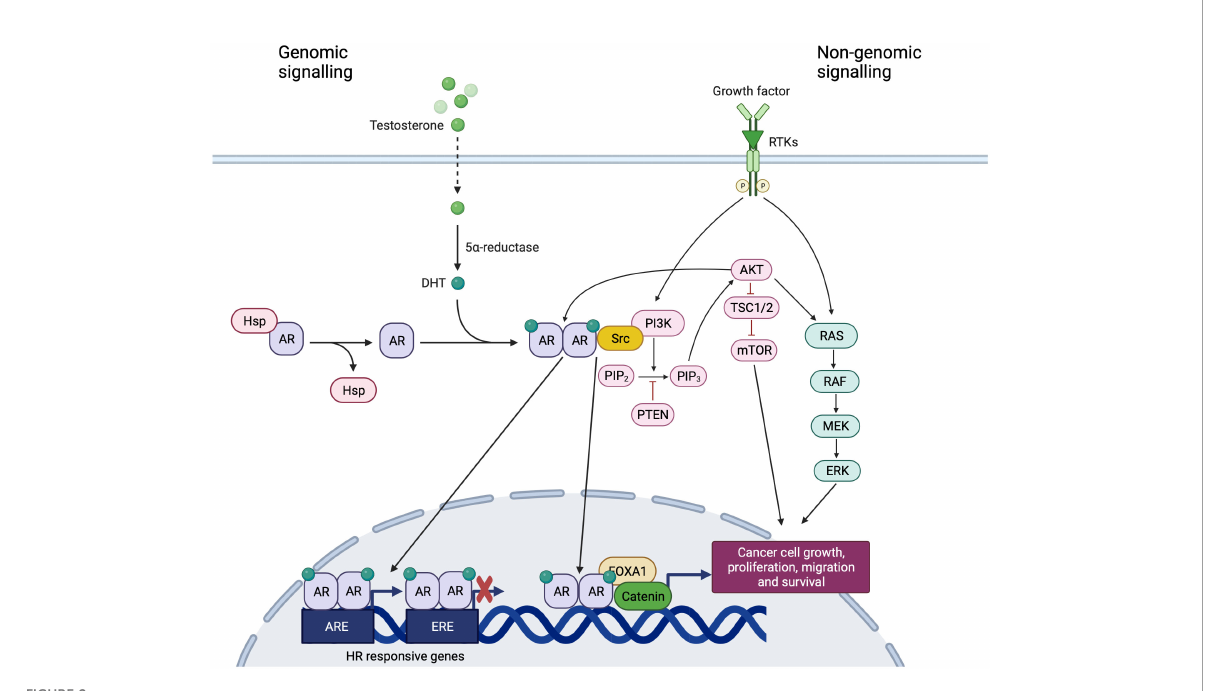
FIGURE 2 Genomic and non-genomic signaling of AR. Created with BioRender.com. In the absence of ligand, AR is located in the cytoplasm and is associated with heat-shock and other chaperone proteins. The binding of AR with androgens leads to the translocation of the complex to the nucleus, causes its dimerization and the binding to AREs, within classical target genes to modulate transcription. AR signaling exerts inhibitory effects on cell growth, interacting and binding to EREs and competing with ER. The DNA binding independent actions of AR are also commonly referred to in the literature as ‘ non-genomic ’ AR signaling with the downstream activation of alternative pathways, involving extracellular signal- regulated kinase (ERK), akt serine/threonine kinase (AKT) and mitogen- activated protein kinases